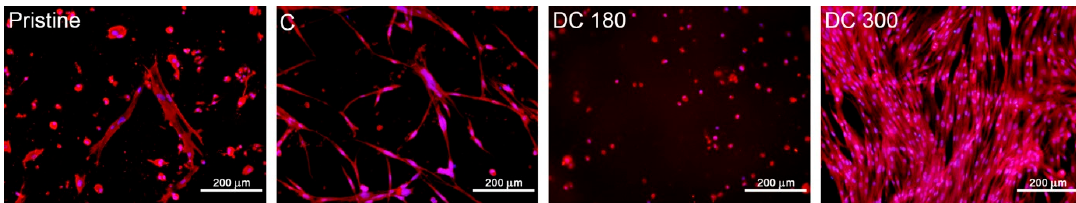
Figure 3. Human dermal fibroblasts on bacterial cellulose in a pristine state (Pristine), loaded with curcumin (C) or with degraded curcumin at 180 °C (DC 180) or at 300°C (DC 300) after seven days of cell seeding. The cells were stained with Texas Red C2-Maleimide (red fluorescence, cell membrane and cytoplasm) and Hoechst #33258 (blue fluorescence, cell nuclei). Olympus IX 50 microscope, obj. 10x, DP 70 digital camera (Olympus, Tokyo, Japan).